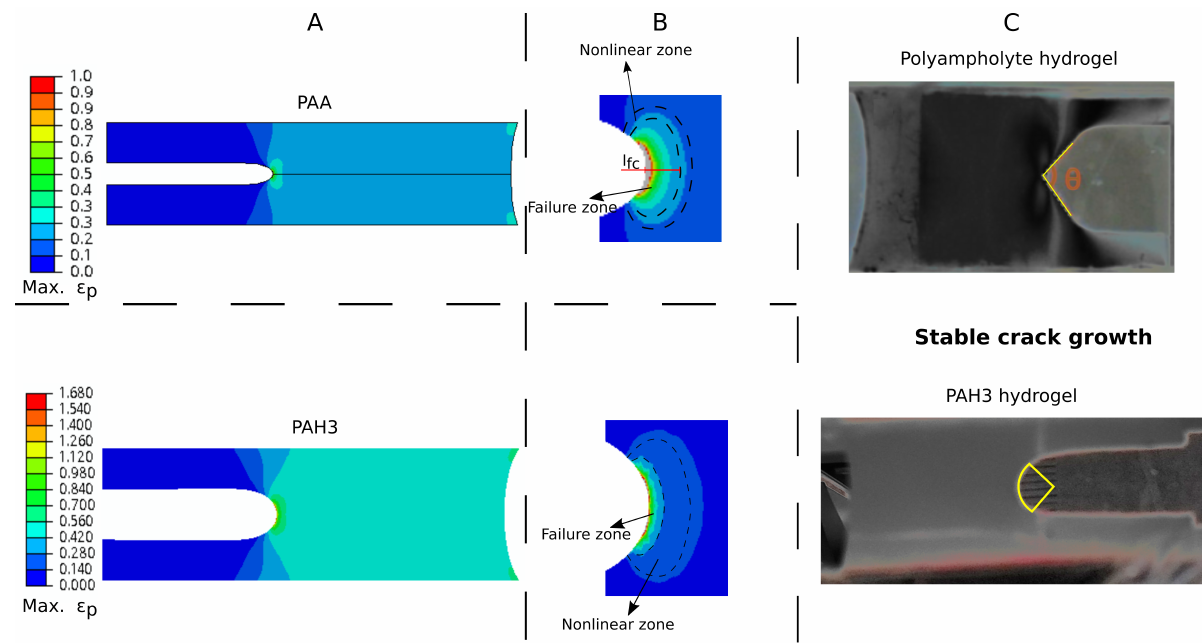
Figure 10. Fracture details for hydrogels containing an initial long notch, under pure shear test. ( A ) Distributions of maximum principal strain (true strain), (cid:101) p , for PAA (top) and PAH3 (14 wt%) (bottom), at the moment of crack initiation. ( B ) A zoom-in on the crack tip region. The contours correspond to the elastic strain energy density distribution. Three regions are separated by black dashed lines. ( C ) Photographs of steady-state crack growth in the notched samples, made of (top) a polyampholyte hydrogel, adapted from the work by Luo et al. [43] with permission, and (bottom) PAH3 hydrogel in this work. Note that the original photographs in C have been converted to greyscale for better